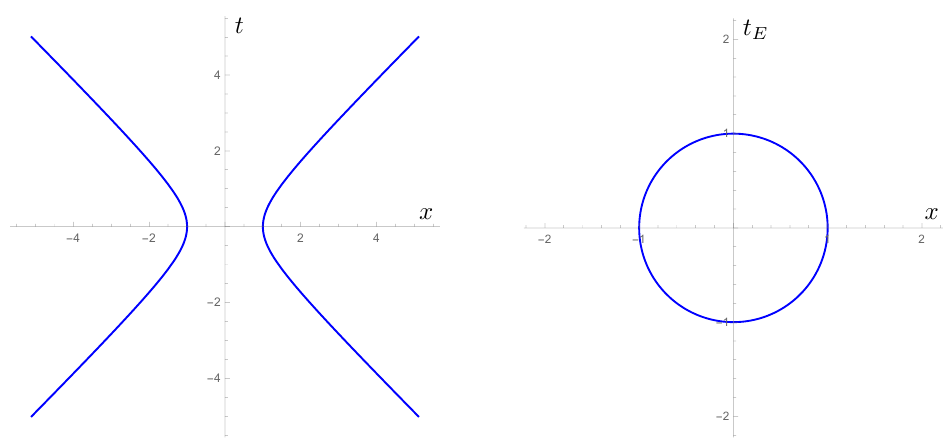
Figure 1 . Left: hyperbolic trajectory of a pair of particles undergoing constant proper acceleration. Right: Euclidean analytic continuation of the instanton describing pair